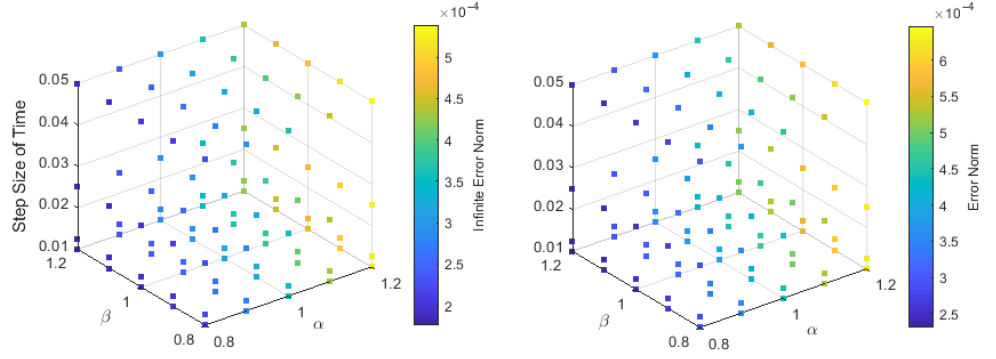
Figure 6. The error functions (cid:107) e n (cid:107) ∞ and (cid:107) e n (cid:107) computed when α equals 0.8, 0.9, 1.0, 1.1, and 1.2 and β equals 0.8, 0.9, 1.0, 1.1, and 1.2.